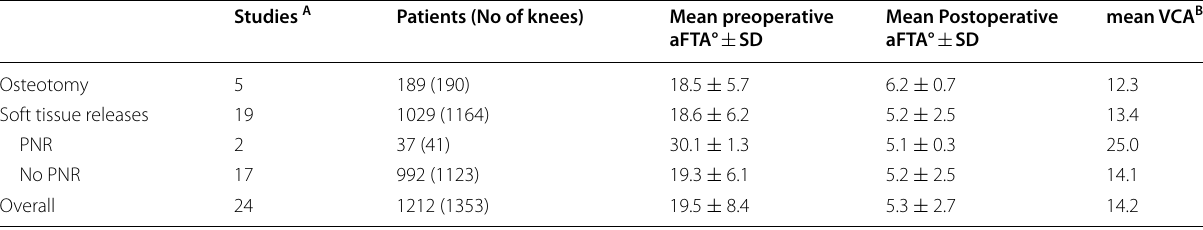
CPNP Common peroneal nerve palsy, VCA Valgus correction angle, aFTA Anatomical femorotibial